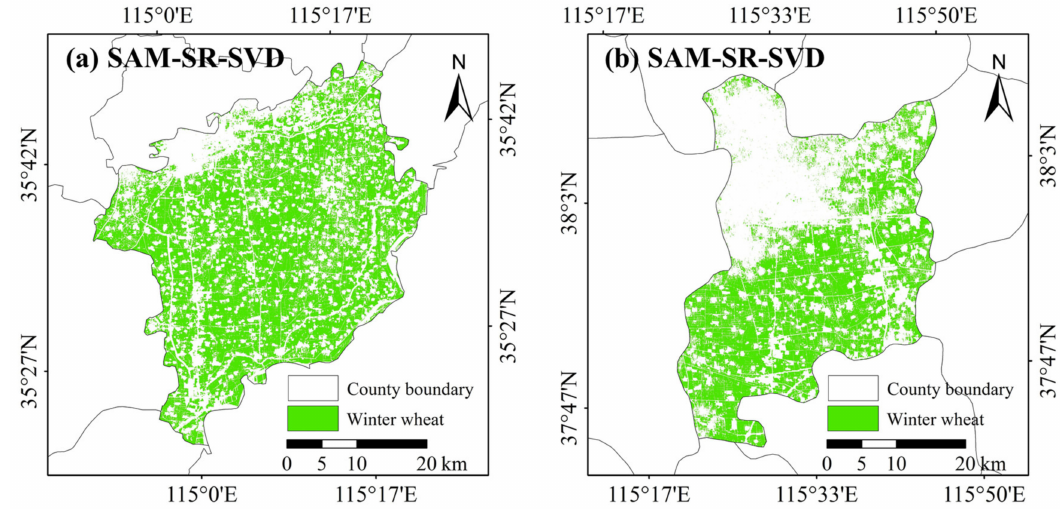
Figure 7. Winter wheat mapping results in Puyang County ( a ) and Shenzhou City ( b ) based on SAM-SR-SVD. Table 3. Comparison of the accuracy of winter wheat mapping by different methods.